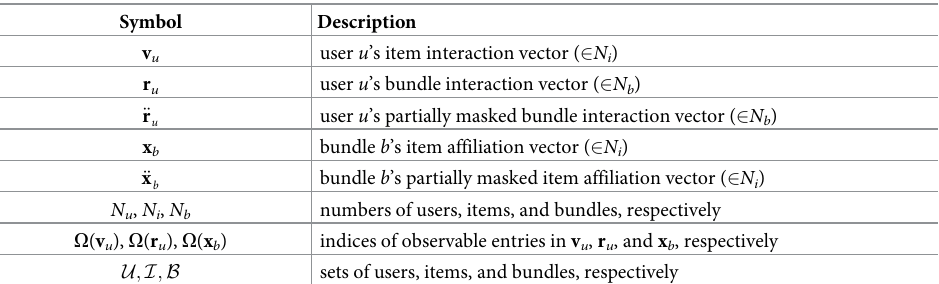
Table 1. Table of frequently used